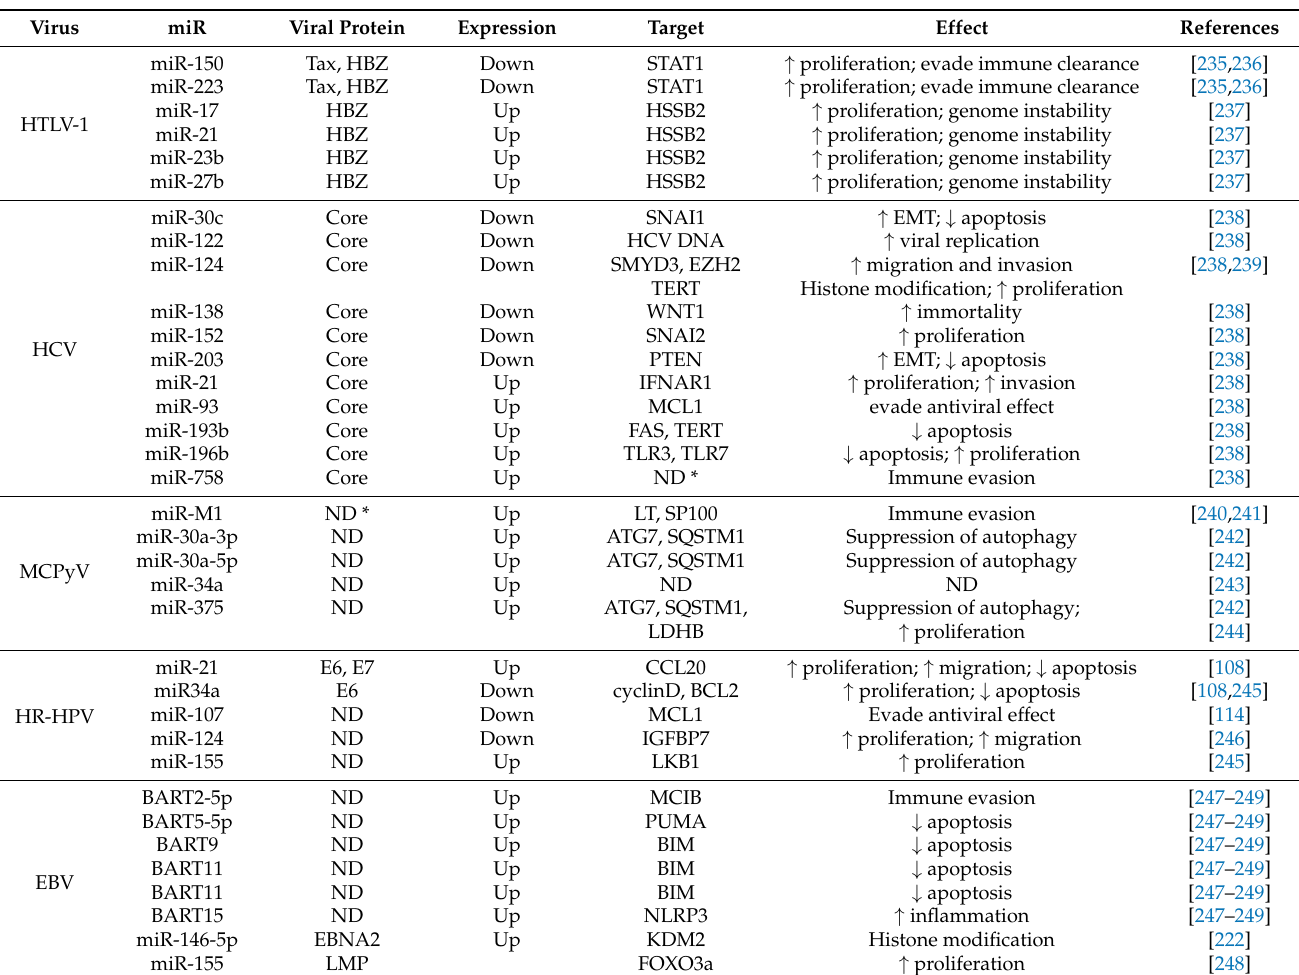
Table 3. Some of the microRNAs affected by human tumor viruses. See text for details. Virus miR Viral Protein Expression